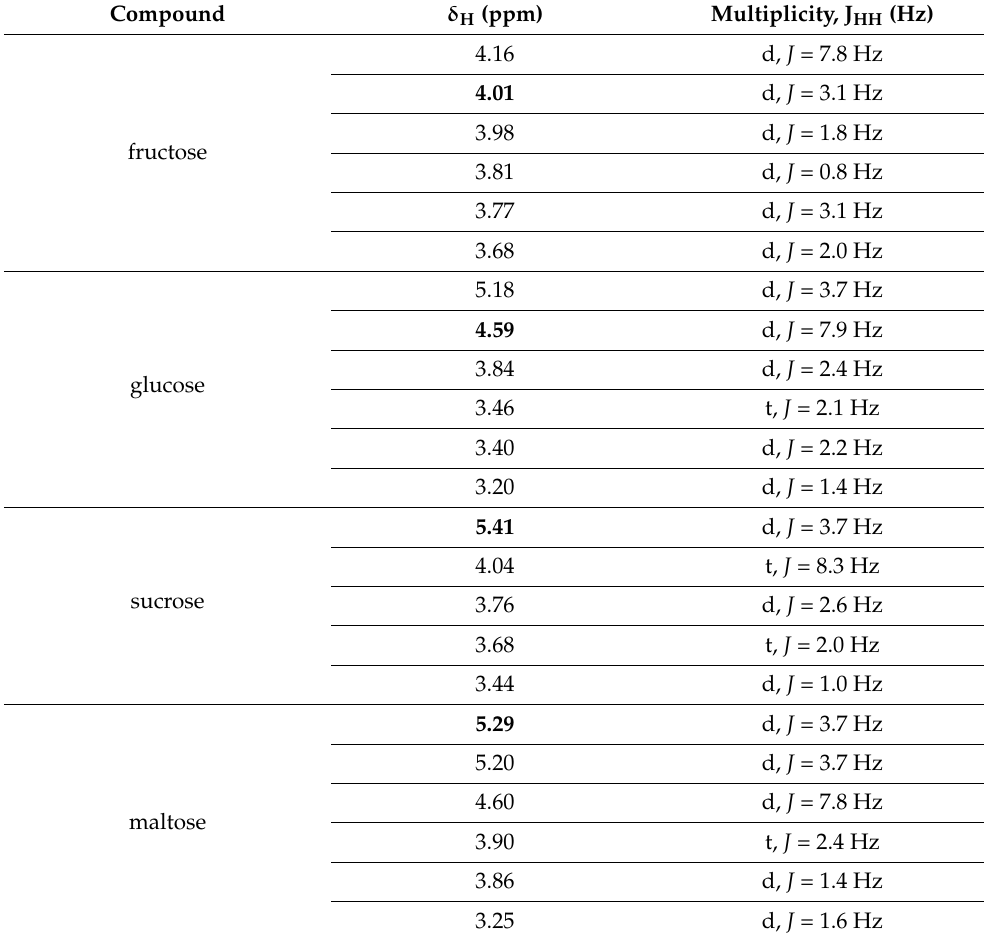
Numbers in bold represent the selected quantitative peak. d, double peak; t, triple